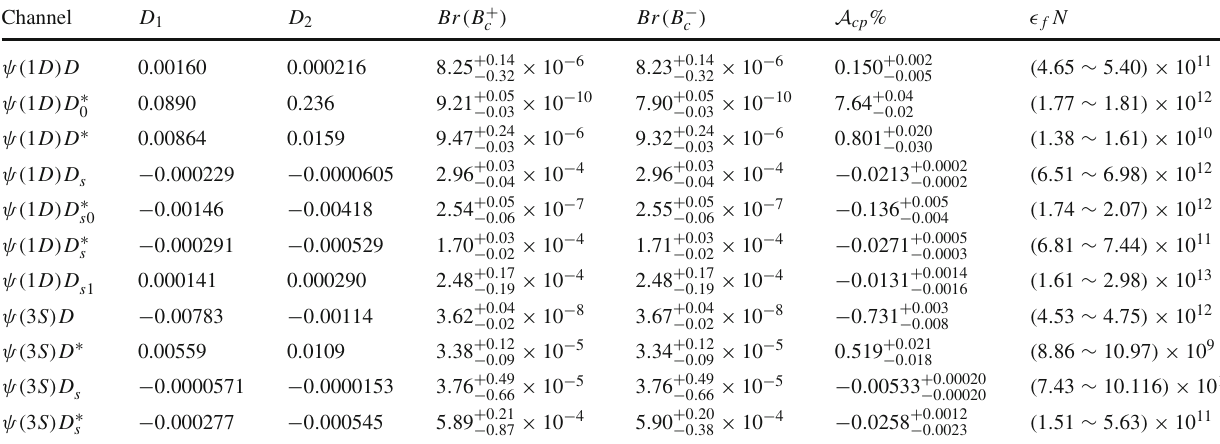
Table 5 The results for B c → c ¯ c ( 1 D ) + ¯ cq ( 1 S , 1 P ) and B c → c ¯ c ( 3 S ) + ¯ cq ( 1 S